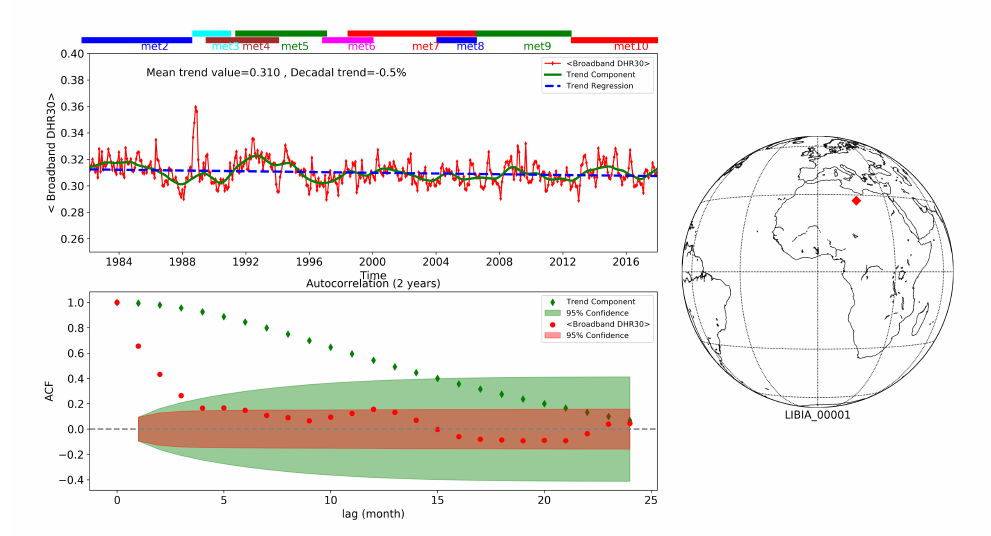
Figure 6. LIBIA_00001 DHR30 time series. The location of the site is shown in the map on the right hand side. Upper plot: monthly averaged broadband DHR30 (red), trend component (green) and trend linear regression (dashed blue). Bottom plot: Auto correlation function (ACF) up to 24 months for the monthly averaged broadband DHR30 (red dots) and for the trend component (green diamonds). The corresponding 95% confidence regions are also displayed. Only lags inside those areas are statistically